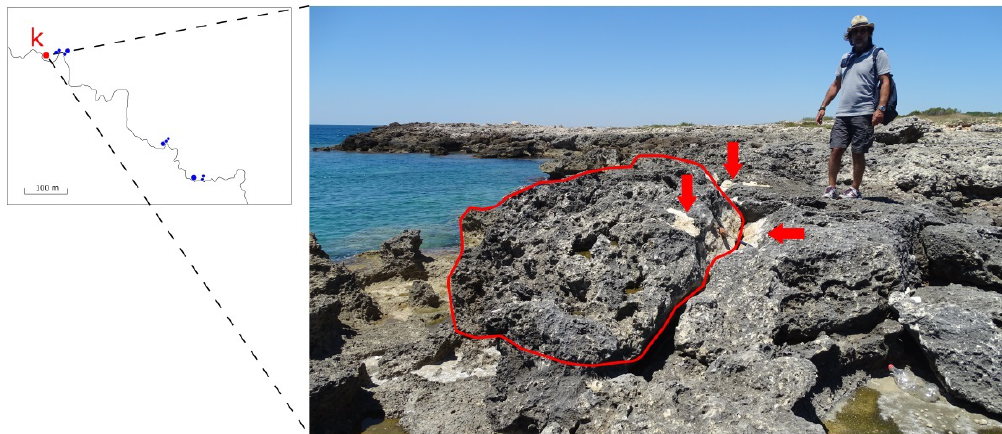
Figure 10. Photo of Boulder k taken parallel to the b × c plane; the arrows indicate the shear failures on the rocky